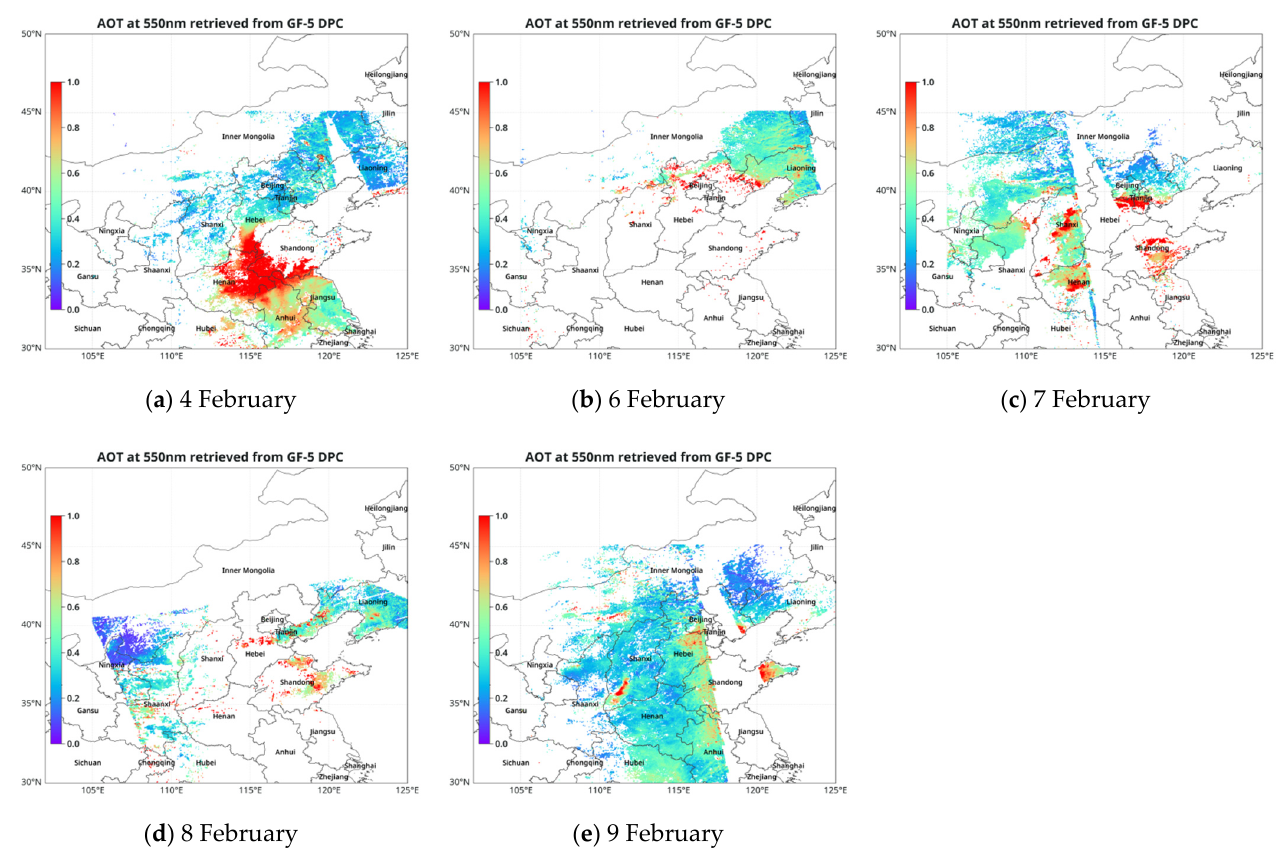
Figure 13. The retrieved AOD with DPC over northern China from ( a – e ) 4 February to 9 February 2020.